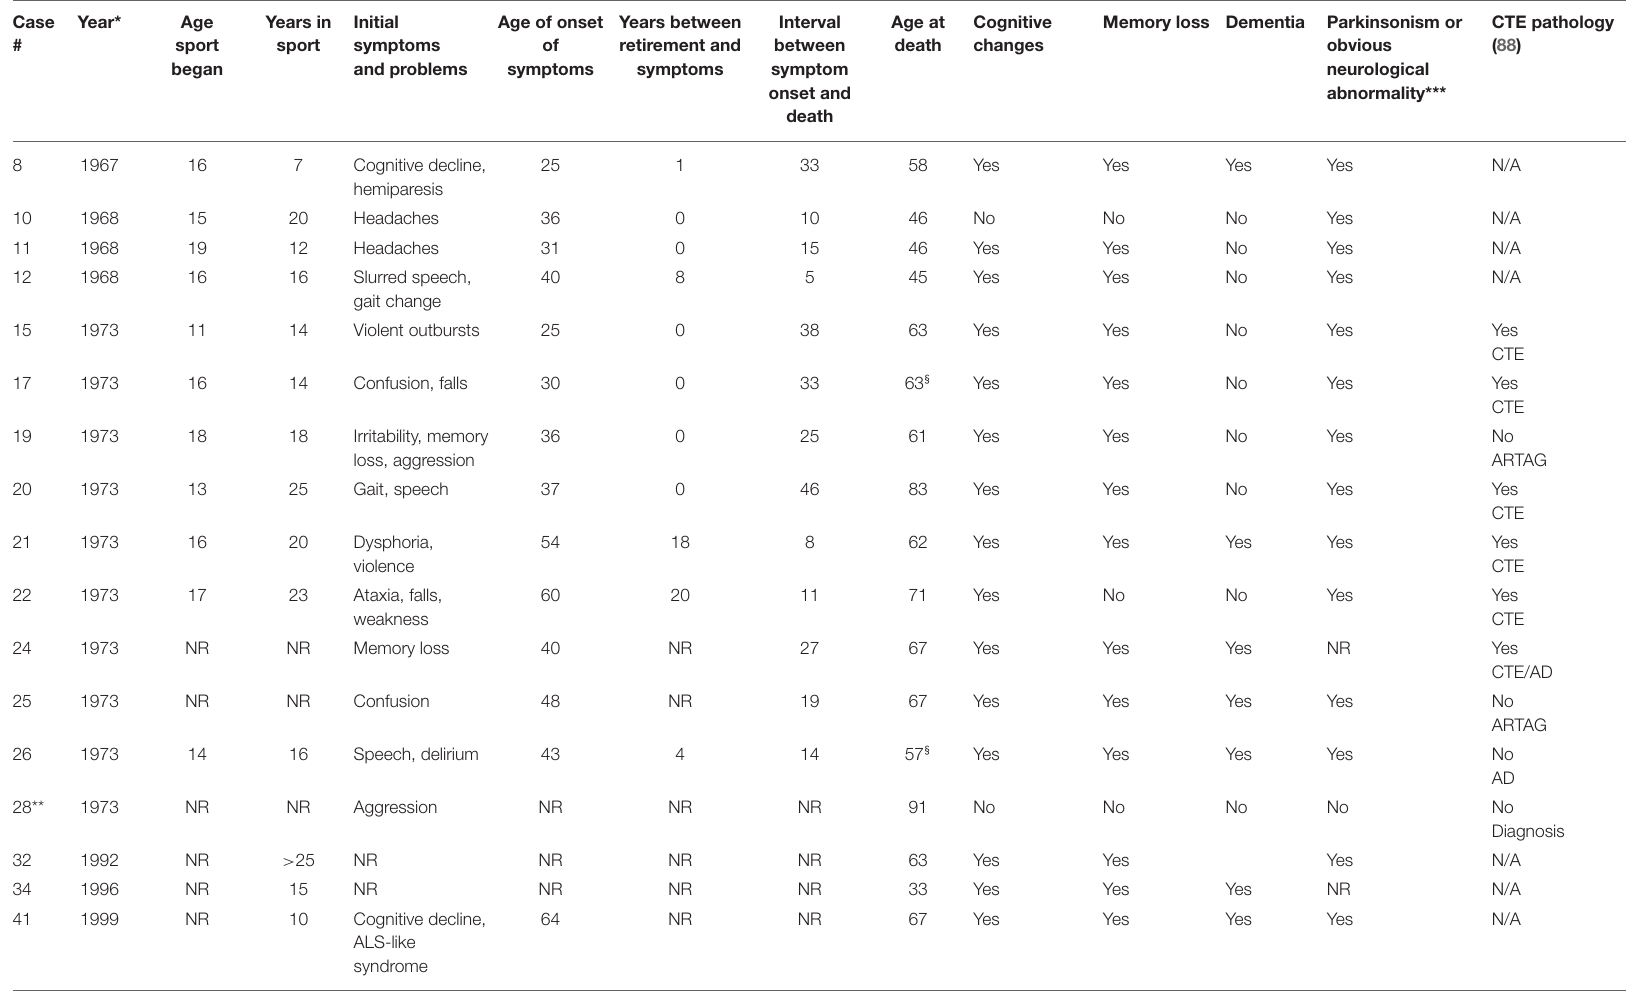
TABLE 4 | Twentieth century case studies of presumed CTE with a history of violence or aggressiveness ( n = 17) from McKee et al.